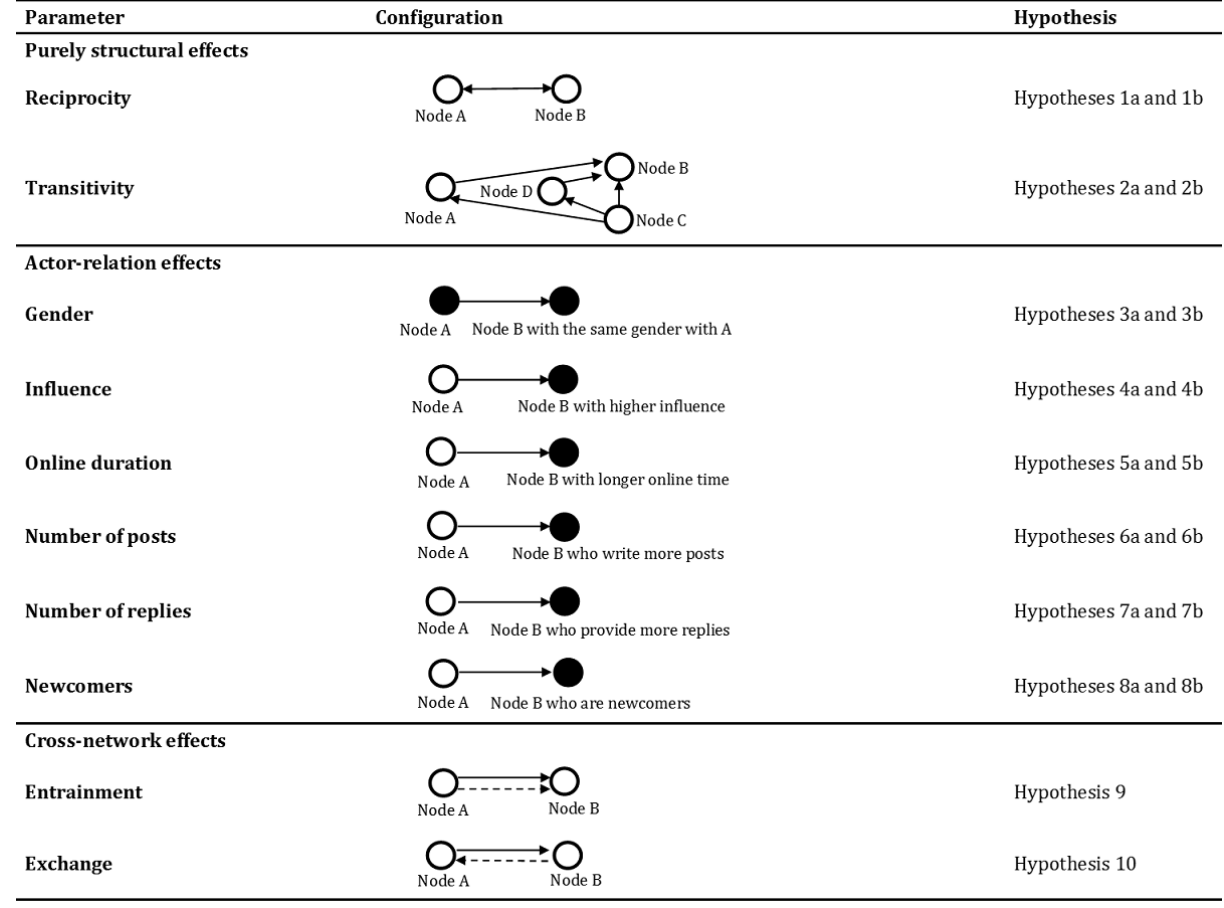
Figure 3. Summary of network configurations included in the exponential random graph